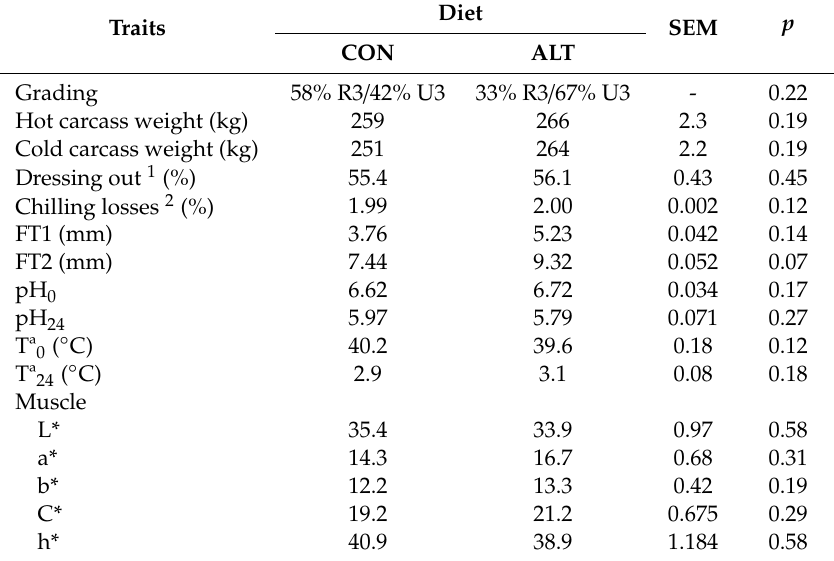
Table 3. Carcass characteristics of crossbred Limousine heifers finished on a conventional concentrate (CON) or a concentrate rich in agro-industrial by-products